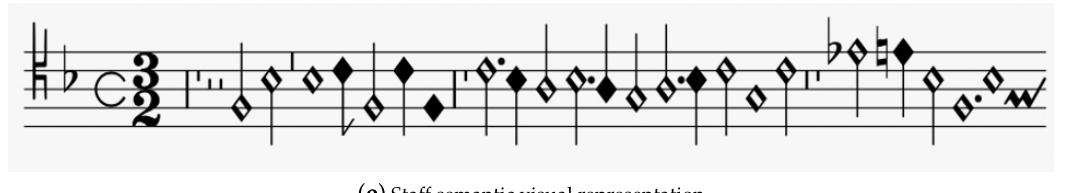
( f ) Staff semantic encoding (in order to save space the space separator has been used instead of the actual end of line) Figure A2. ( a ) Sample of a music staff from the Zaragoza corpus. ( b ) This staff is a rendering of the music symbols found in the image by a OMR tool, as encoded in ( c , d ). ( e , f ) The semantic encoding of the